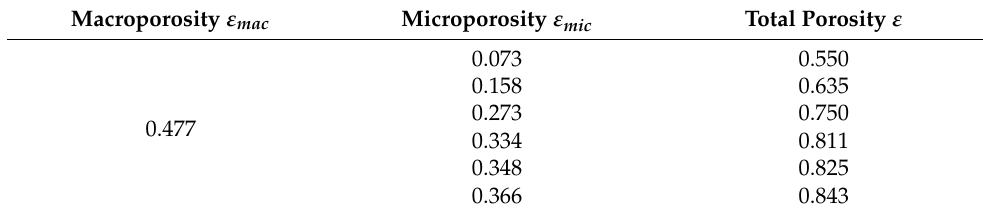
Figure 7. Examples of a packing model for spheres with micropores. Table 2. Porosity value of the created